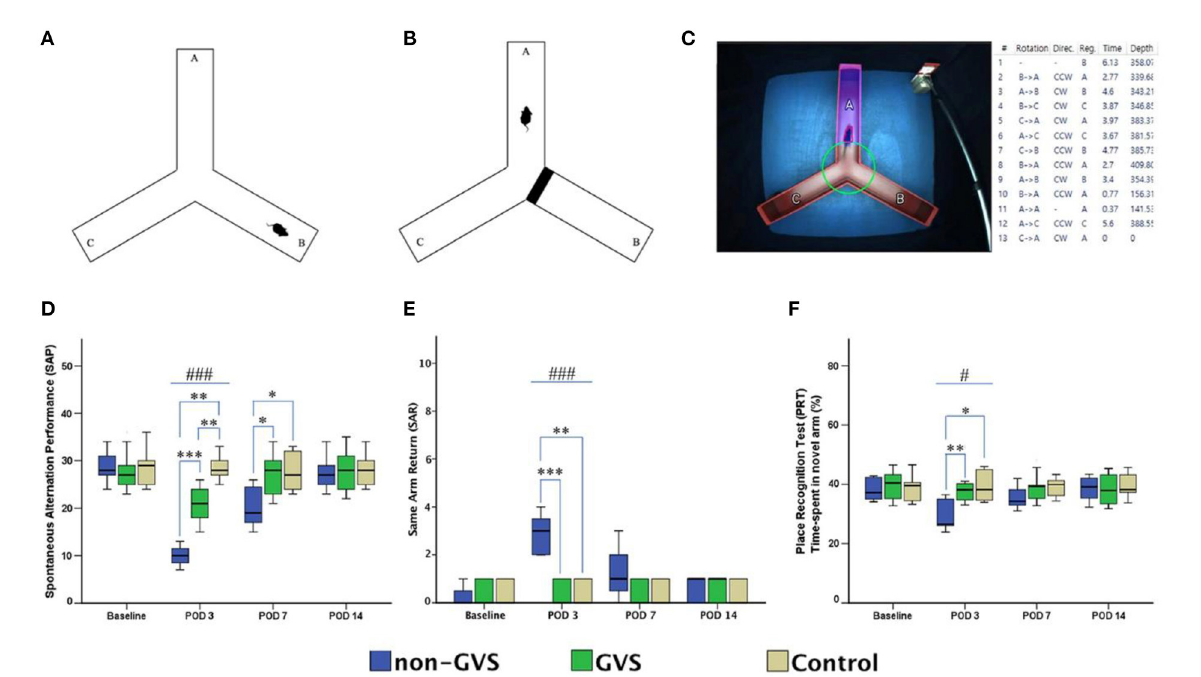
FIGURE3 Evaluation of locomotor activities and spatial navigation through the Y maze test. The mice move freely within three arms (A) . Mice were trained with a block in the B arm for 3min, then the block was removed, and the mouse activity for exploring the B arm was assessed, i.e., the place recognition test (B) . Mice activities in the three groups of non-GVS, GVS, and control groups were tracked and computed by analysis software in 6min at four time points: baseline, and post-operative days (PODs) 3, 7, and 14 (C) . There was a significant difference between the groups in the spontaneous alternation performance at PODs 3 ( χ 2 = 17.11, p < 0.001, Kruskal–Wallis test). This decline in the non-GVS group continued until POD 7 as compared to the GVS group ( Z = − 2.12, p < 0.05) and control group ( Z = − 1.95, p < 0.05) (D) . There was also a significant difference between the groups in the same arm return at POD 3 ( χ 2 = 15.23, p < 0.001, Kruskal–Wallis test) (E) . The place recognition test indicates spatial reference memory and it shows a significant difference between the groups at POD 3 ( χ 2 = 7.63, p < 0.05, Kruskal–Wallis test) (F) . Values of significant difference were calculated by using the Kruskal–Wallis test for between groups and the Mann–Whitney U- tests for pairwise comparisons. *Significantly different between two groups; # Significantly different between three groups; * , # p < 0.05; ** , ## p < 0.01; *** , ### p < 0.001. Reproduced from Nguyen et al.